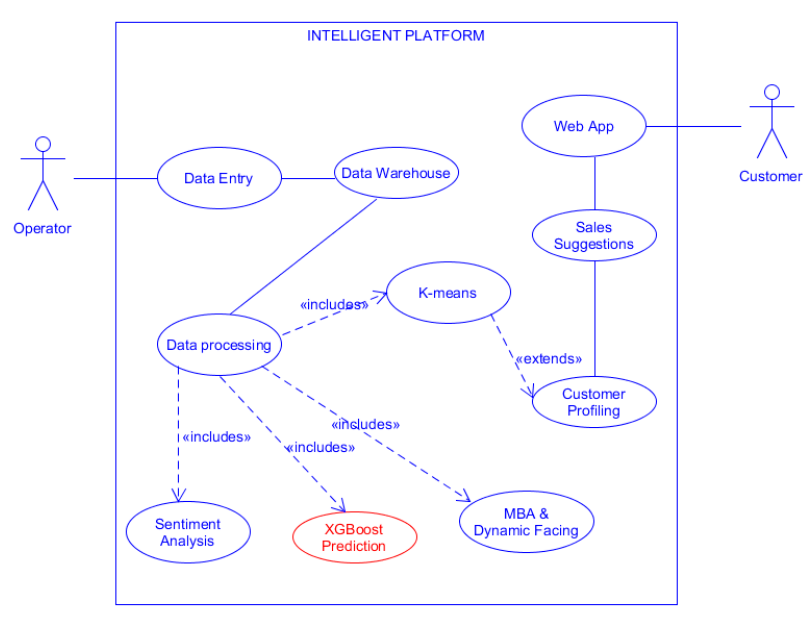
Figure 2. UML UCD of the implemented prototype platform with focus on data processing.